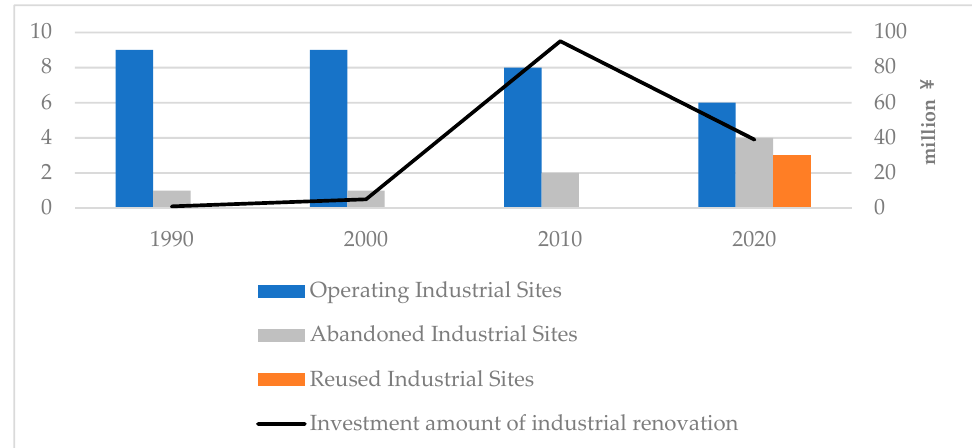
Figure 29. The change in the relationship between the operation state of resource-intensive industries and the investment amount of industrial renovation over time (Figure source: own drawing; data from: [83]).